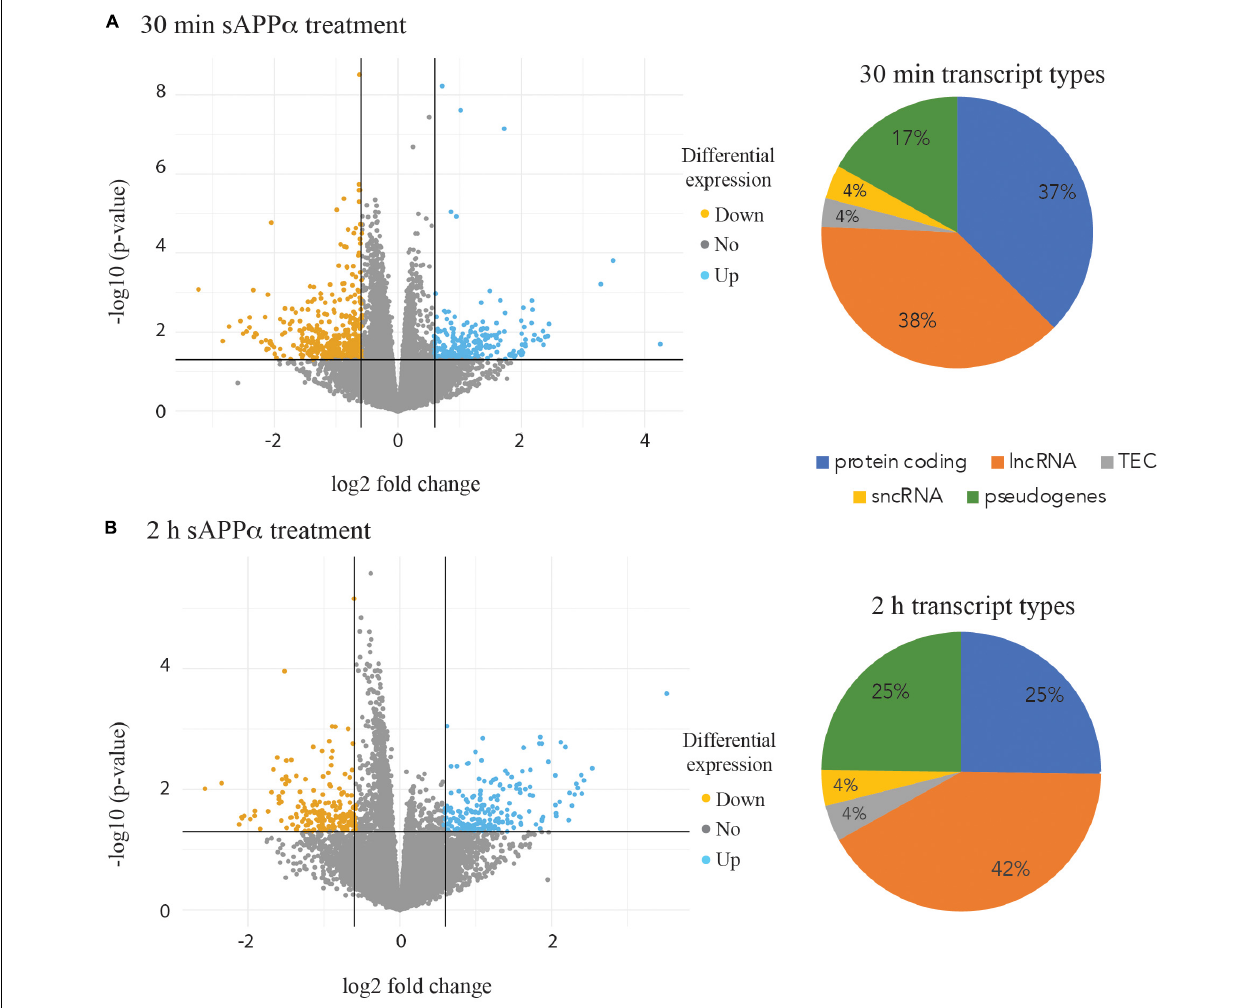
FIGURE 3 | Volcano plots highlighting differential expression of individual transcripts. Transcripts down regulated (orange points) and up regulated (blue points) are shown after 30 min (A) and 2 h incubation of the human neurons with 1 nM sAPP α (B) . Pie charts illustrating the proportion of biotypes within the group of significantly differentially expressed transcript groups in the 30 min (A) and 2 h (B) data. lncRNA – long non coding RNA, sncRNA – short non coding RNA, TEC – transcript type to be experimentally